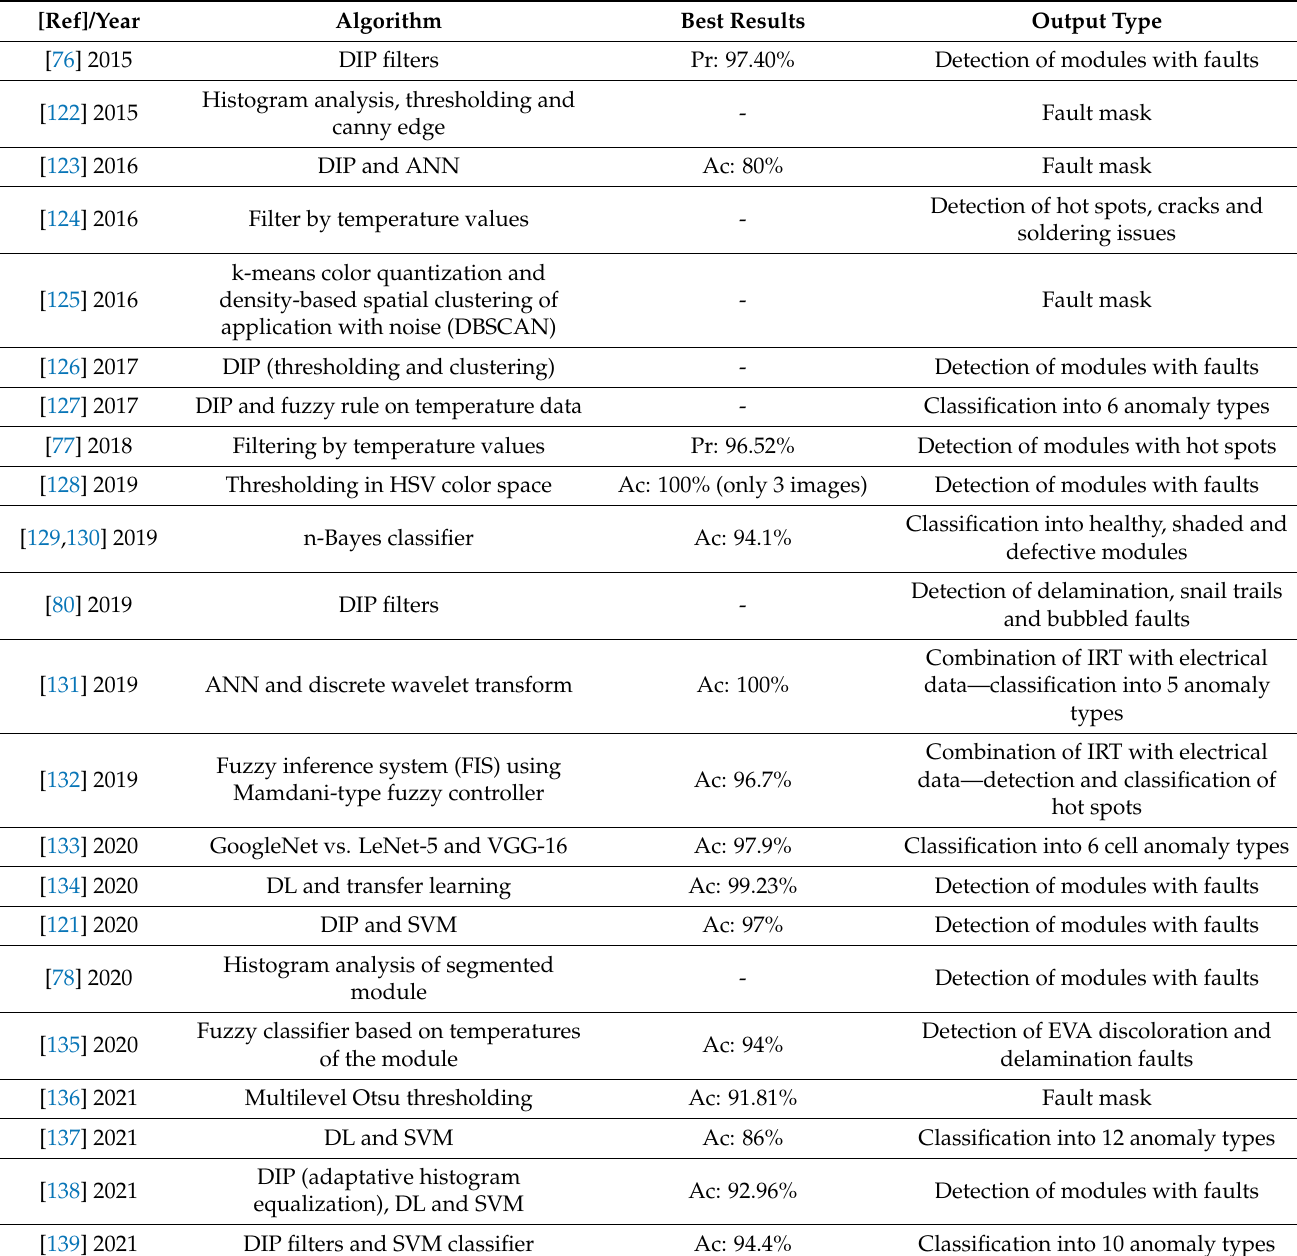
Table 4. Summary of methods for detecting and classifying faults in IRT images of PV